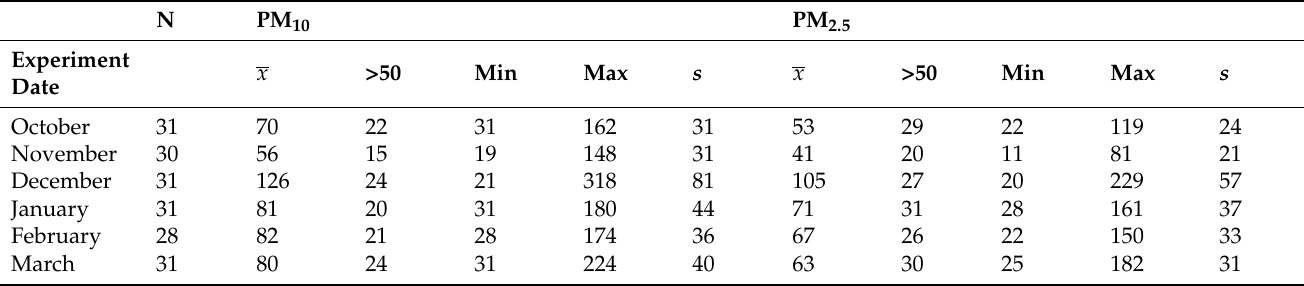
Figure 2. Distribution of daily PM 2.5 concentrations ( μ g/m 3 ) in Chelyabinsk city in the autumn ‐ win ‐ ter season 2020–2021. Table 1. Statistical characteristic of daily dust concentrations of PM 10 and PM 2.5 ( µ g/m 3 ) in